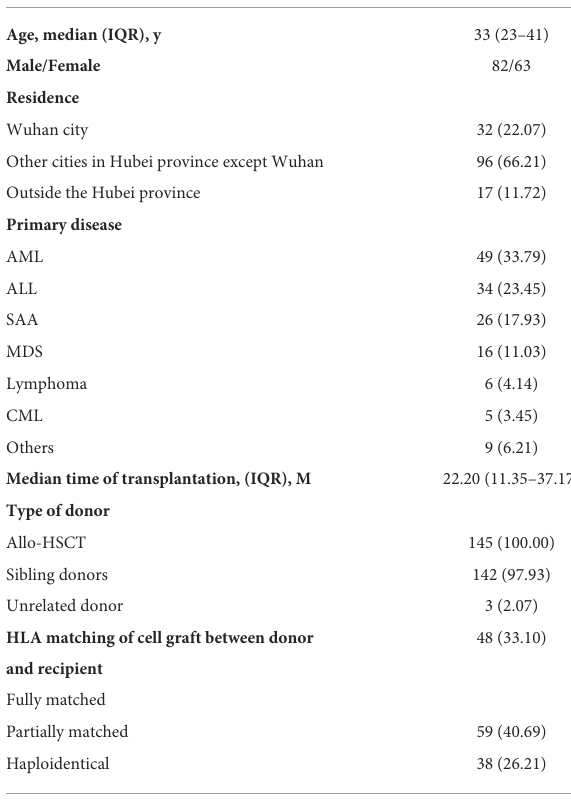
TABLE 1 Characteristics of hematopoietic stem cell transplantation recipients during the COVID-19 epidemic. Characteristics ( N =